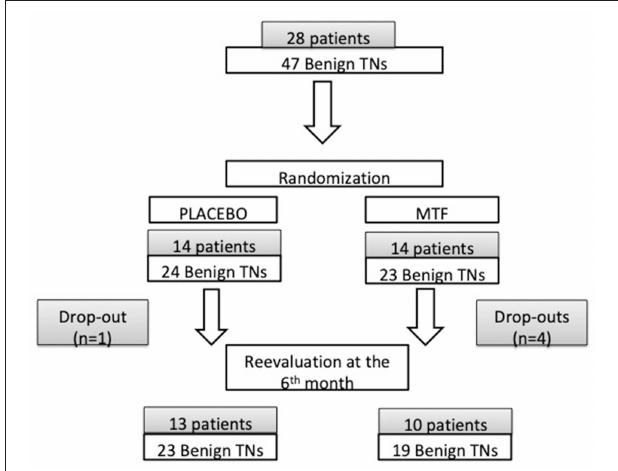
FIGURE 1 | Flowchart of participants in the study.